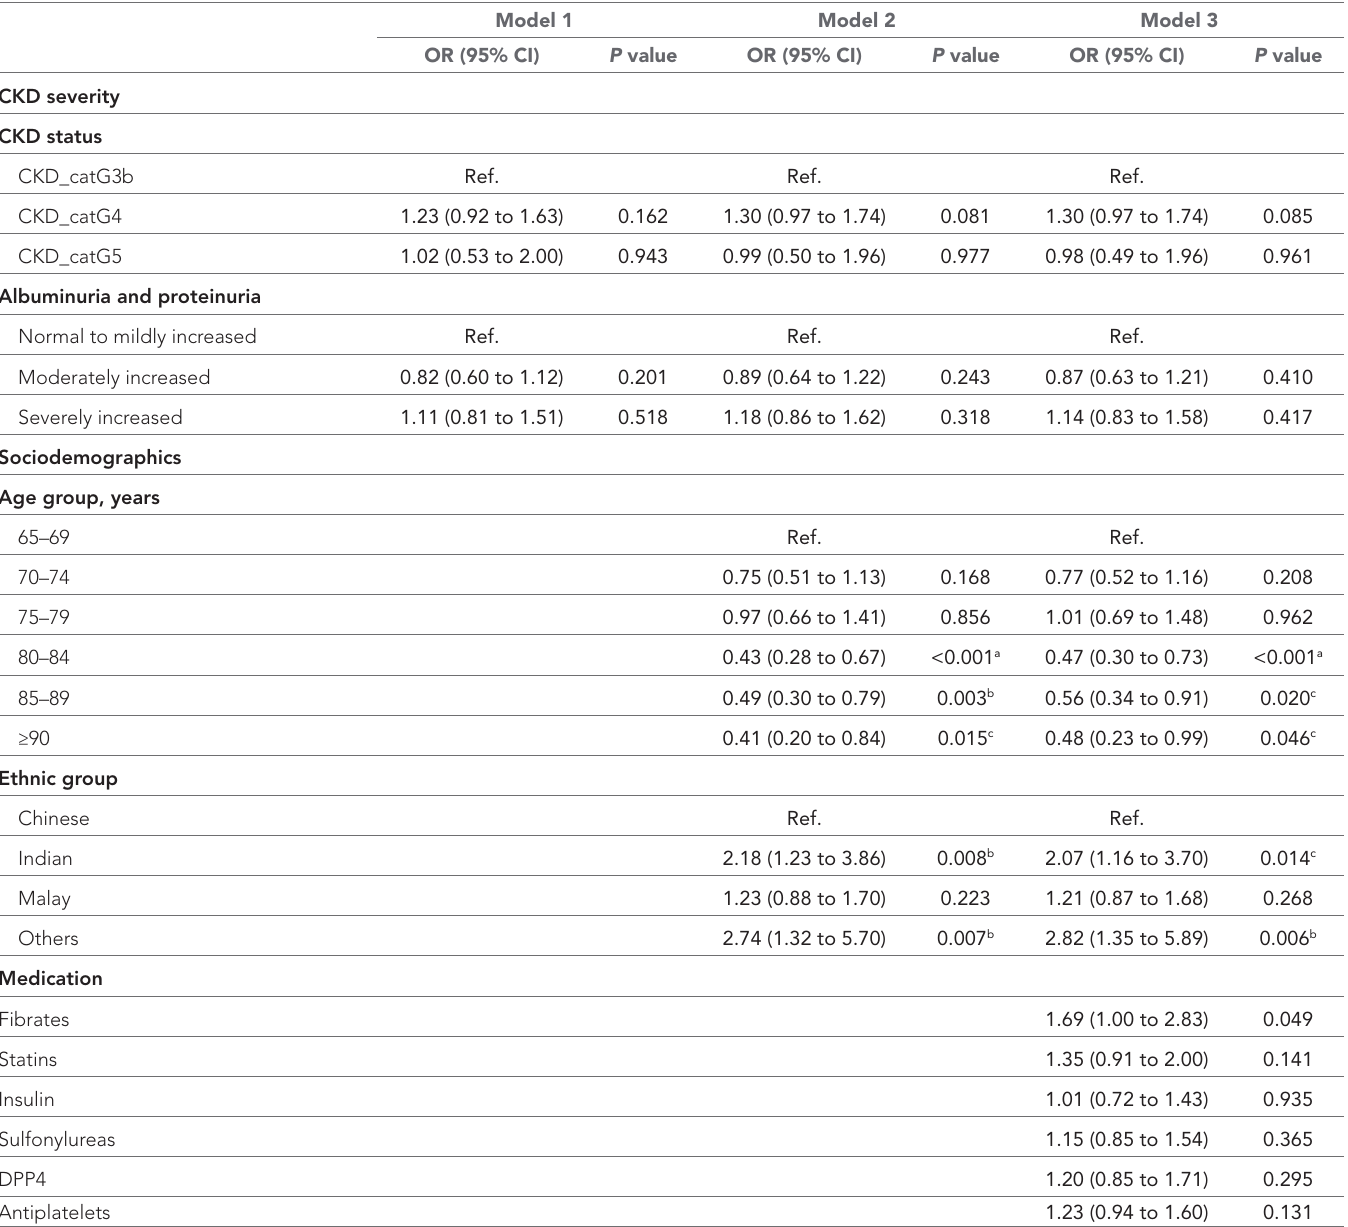
Table 5 Logistic regression predicting likelihood of referral with all variables significant in the bivariate